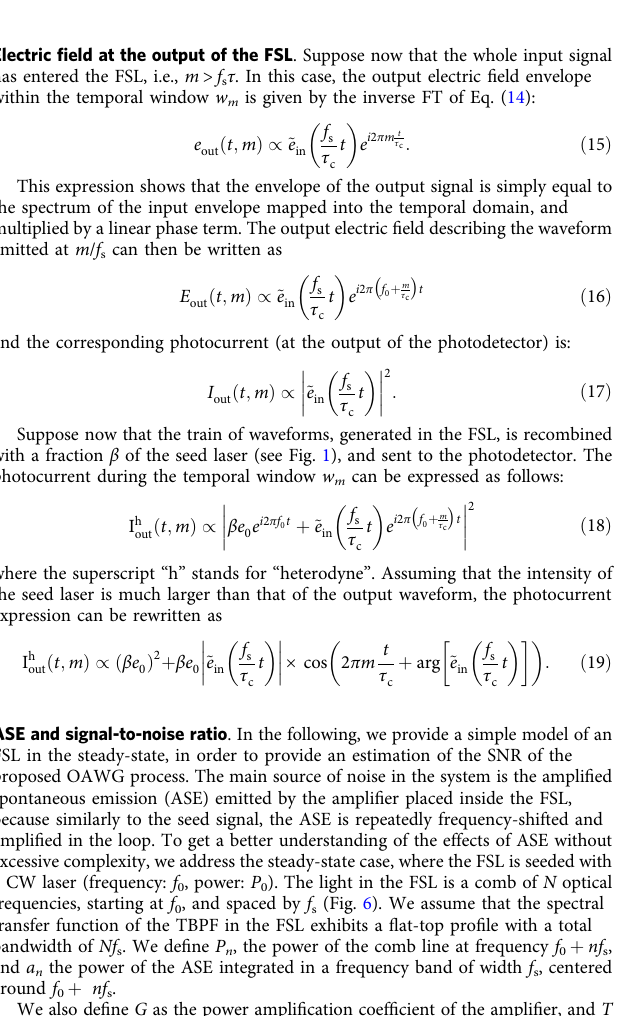
Fig. 6 Optical spectrum in the FSL seeded by a CW laser. The FSL is seeded by a CW monochromatic laser at frequency f 0 . A frequency comb is created in the loop (FSR: f s ), in red. The ASE background is shown in orange. The fi lter transmission function is assumed to exhibit a fl at-top pro fi le